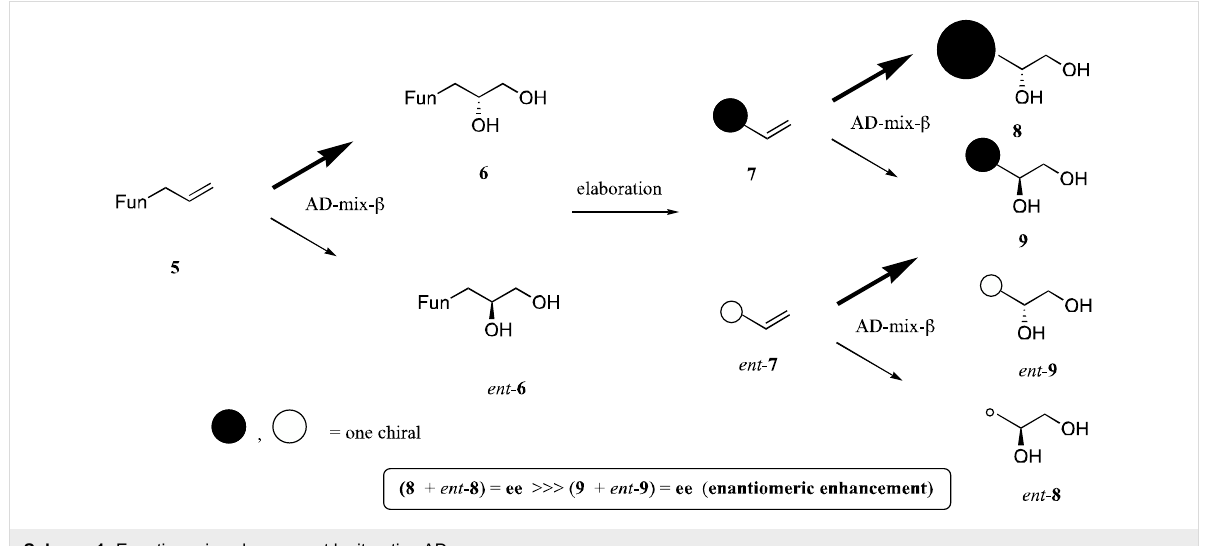
Scheme 1: Enantiomeric enhancement by iterative